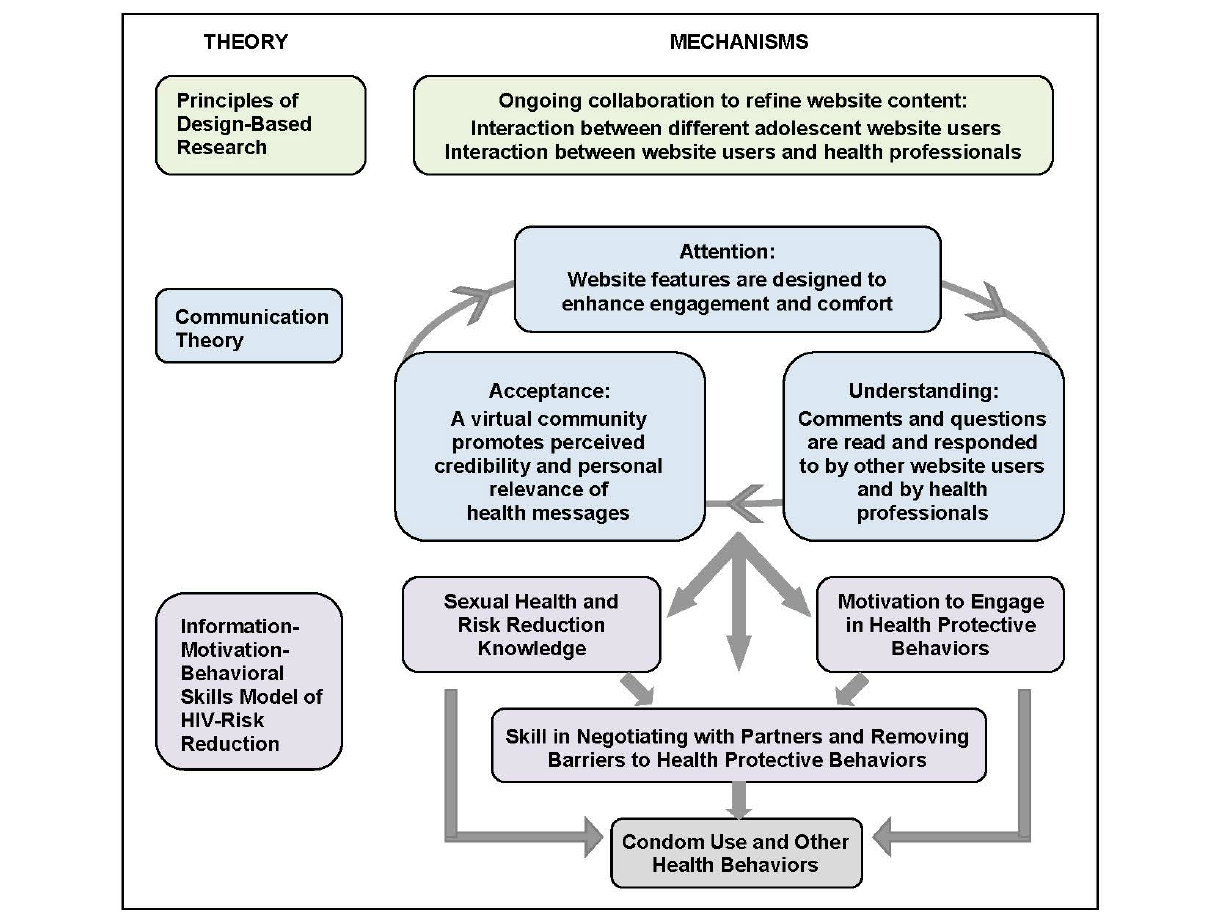
Figure 1. Mechanisms of behavior change with respect to condom use and other health